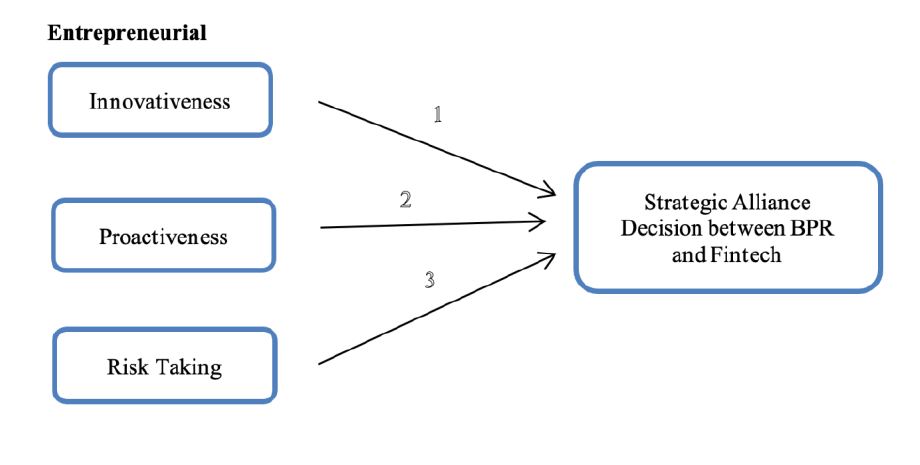
Figure 1: Research Framework and